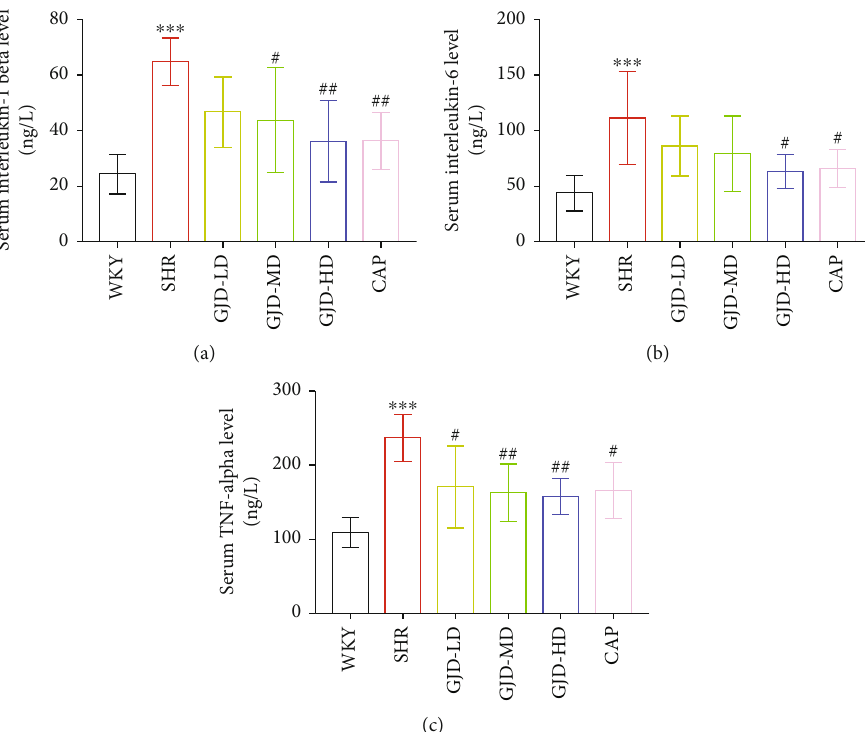
Figure 6: Serum level of interleukin-1 beta, interleukin-6, and TNF-alpha in each group. (a) endothelin-1, (b) angiotensin II, (c) interleukin- 1 beta, (d) interleukin-6, and (e) TNF-alpha. WKY indicates the WKY control group, SHR indicates the SHR model group, GJD-LD indicates the SHR treated with GJD at a low dose, GJD-MD indicates the SHR treated with GJD at a medium dose, GJD-HD indicates the SHR treated with GJD at a high dose, and CAP indicates SHR treated with captopril. Data are means ± SD , n = 7 . ∗ P < 0 : 05 , ∗∗ P < 0 : 01 , ∗∗∗ P < 0 : 001 vs. WKY group, # P < 0 : 05 , ## P < 0 : 01 , ### P < 0 : 001 vs. SHR